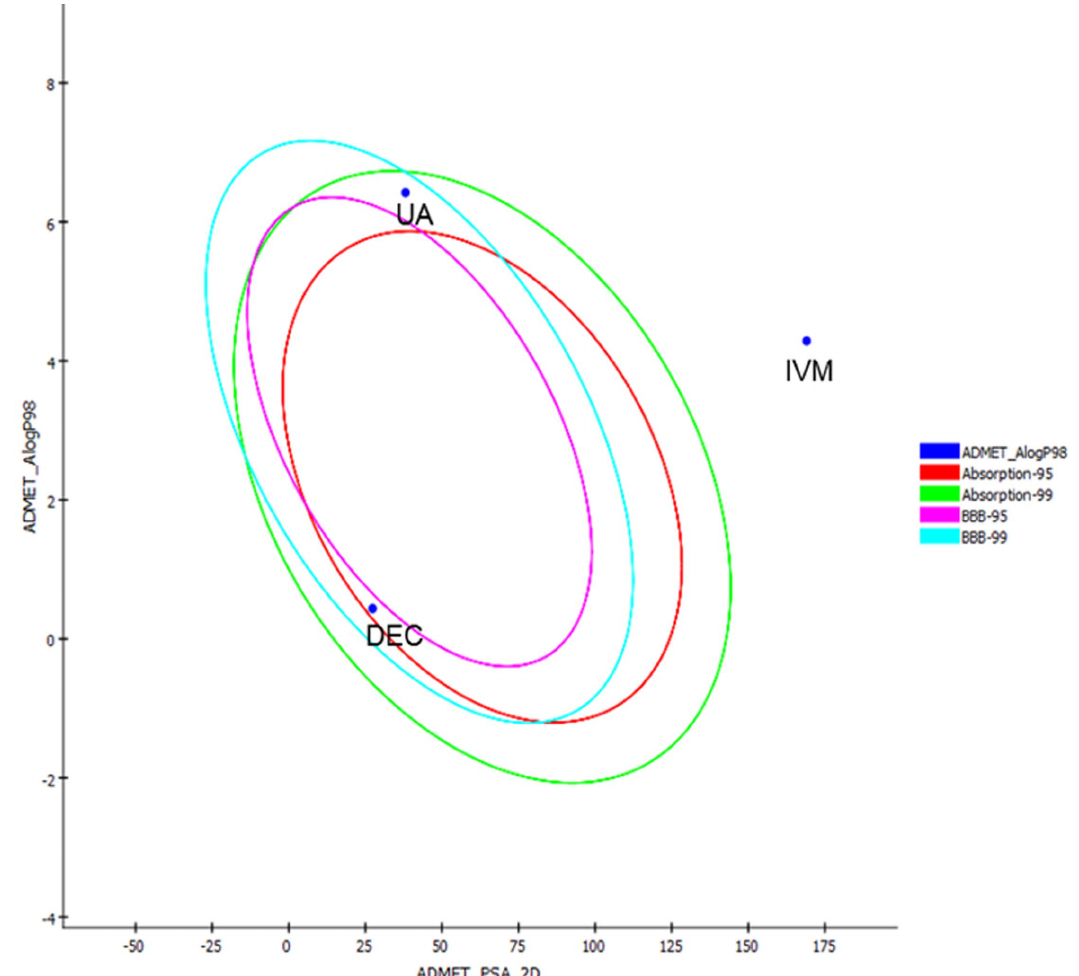
Figure 4. Adsorption model of Ursolic Acid (UA) and the standard antifilarial drugs.